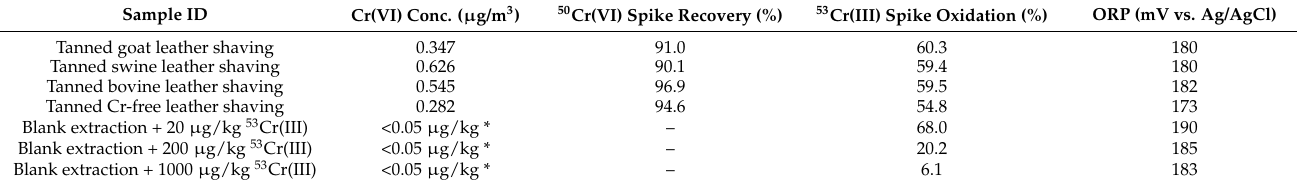
Table 2. Cr(VI) airborne concentrations detected with the NIOSH extraction protocol (fixed-site sampling in four different shaving areas). Data of spikes recoveries/oxidations, together with three blank extractions are presented. ORP values determined after extraction and